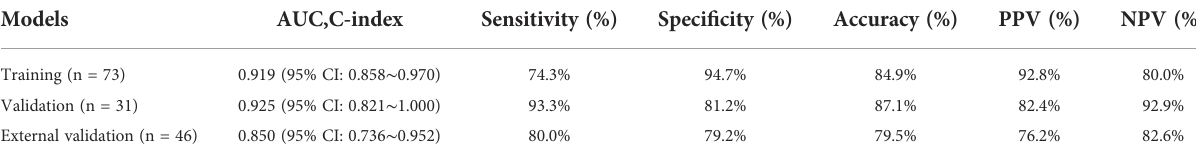
TABLE 5 Predictive performance of preoperative Gd-EOB-DTPA-enhanced MRI features in Ki-67 expression prediction.